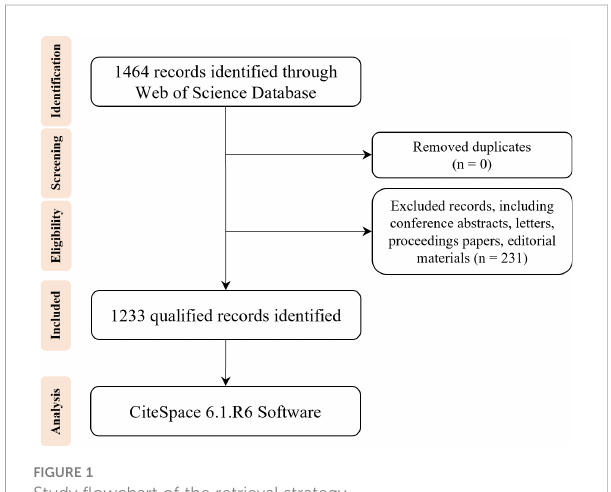
FIGURE 1 Study fl owchart of the retrieval